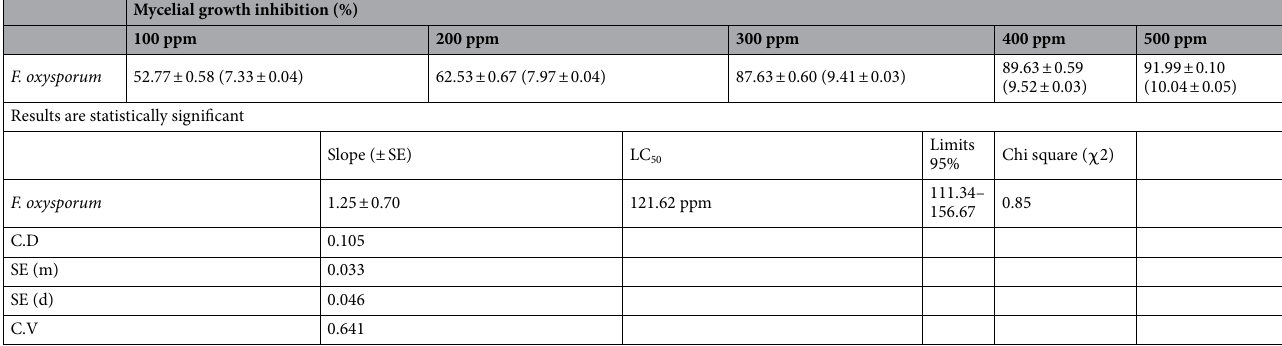
Table 3. Effect of NAFO nanoparticles against mycelial growth of F. oxysporum (in